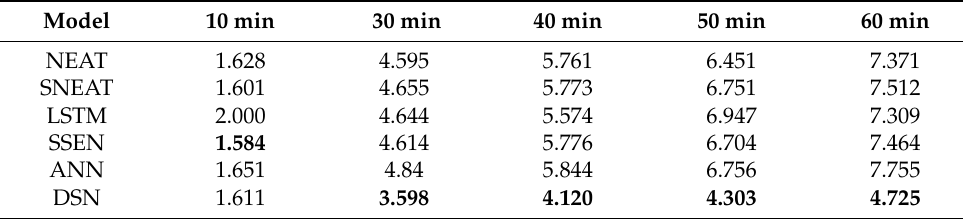
Table 5. CRPS of different NN models distributional forecast (normalized by P max ag ) over the year of 2010.